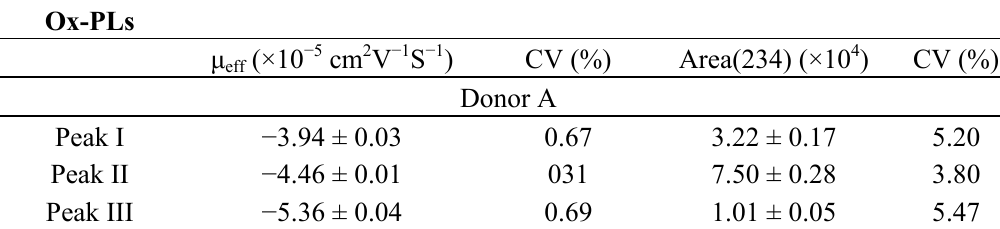
Table 9. The average effective mobility and peak area of in vitro oxidized VLDL phospholipids analyzed by MEKC at absorbance 234 nm (data are means ± SD of four